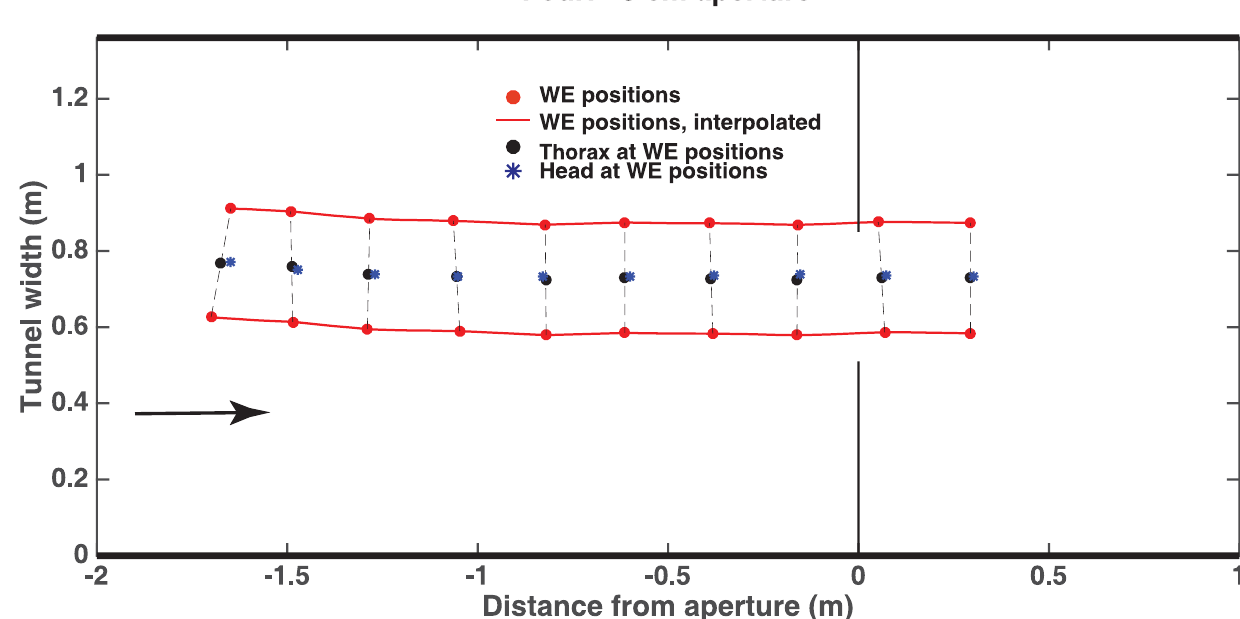
Fig 5. Plan view of a reconstructed flight of bird Four. In this example, the wingspan of the bird is 29 cm and it flies through a 34 cm aperture, which is 5 cm wider than the wingspan. Details in text. The red circles show the wingtip positions at the time of each wing extension, the black circles show the inferred position of the thorax at these instants, and the blue asterisks depict the position of the head at these instants. The red lines show the wing extension trajectories interpolated between wing extensions. The arrow in this and other figures shows the direction of flight. In this figure and subsequent figures (Figs 6–8 and S1-S6 Figs in S1 File), the y axis (“Tunnel width”) refers to the position (in meters) along the width of the tunnel (corresponding to the y axis in Fig 3).